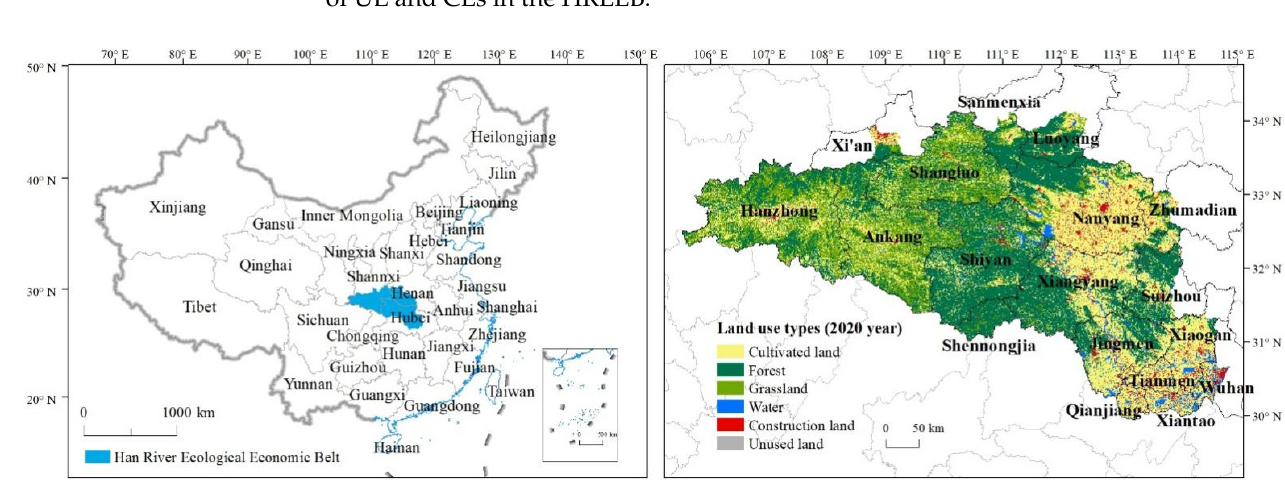
Figure 1. Study area in China.